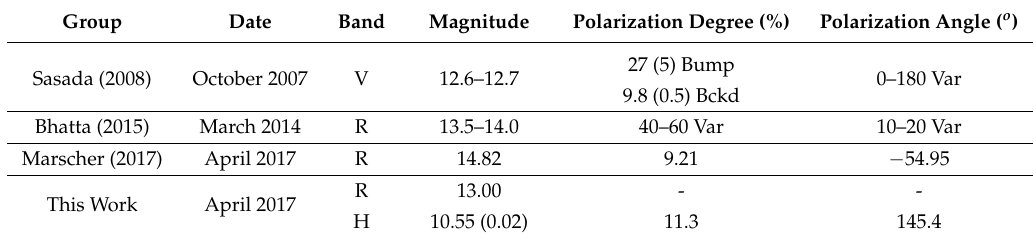
Table 2. Polarization Data